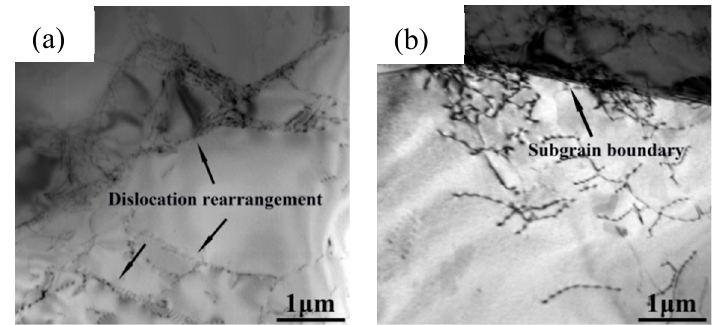
Figure 10. TEM micrographs of the Nb-contained 316LN compressed at 1100 °C, 0.1 s − 1 ( a ) dislocation rearrangement ( b ) subgrain boundary transformation.